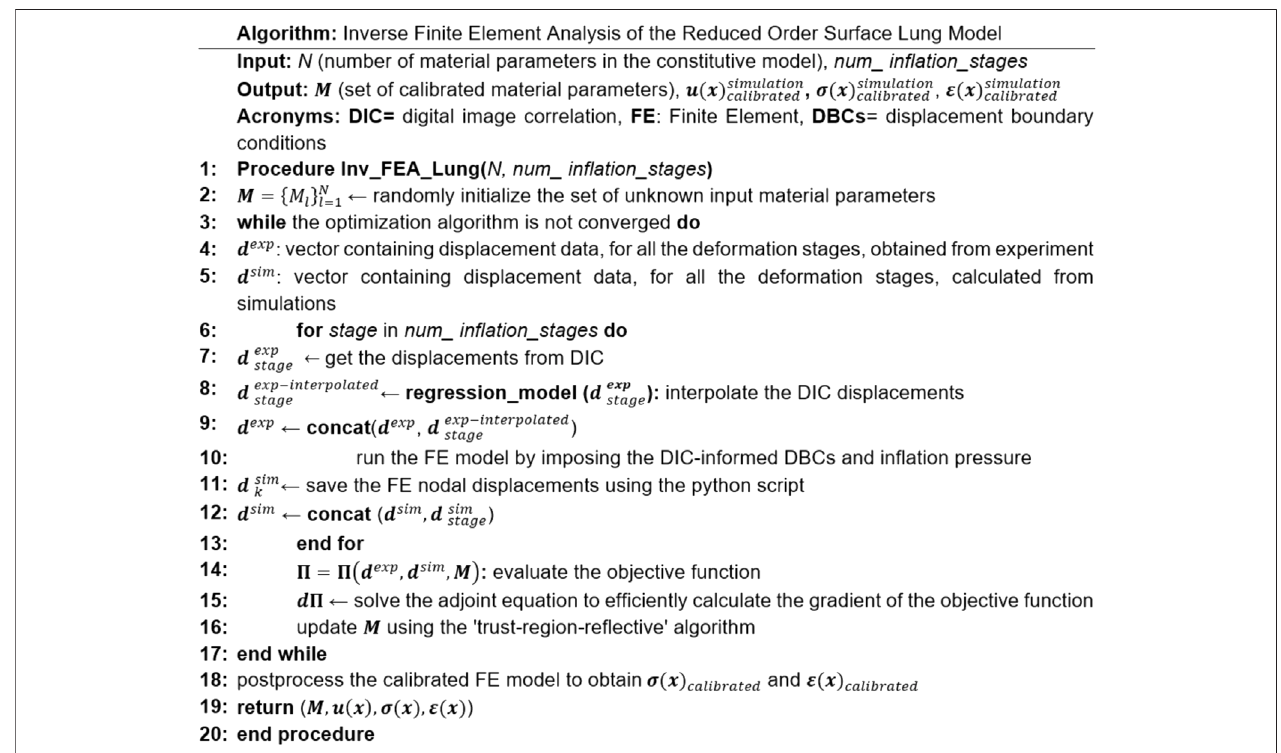
FIGURE 2 | The overall algorithm for the IFEA framework implementation. The model started with an initial estimate for the material parameters, then the optimization algorithm incrementally moved forward toward the optimal solution by minimizing the displacement error between model predictions and DIC measurements. In this work fl ow, u refers to the nodal displacement, σ is the Cauchy stress, ε is the technical